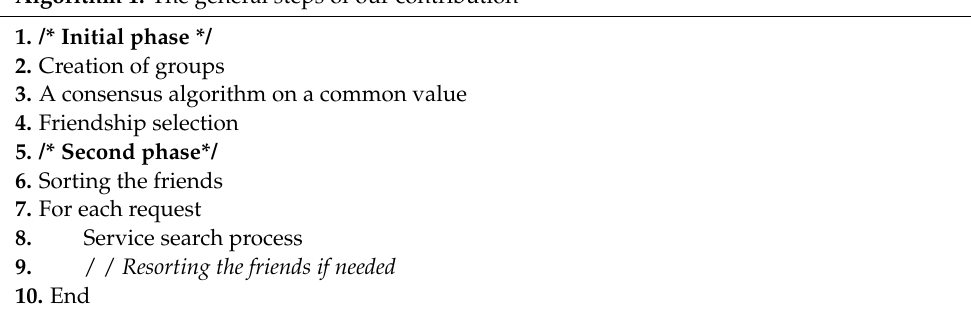
Algorithm 1: The general steps of our